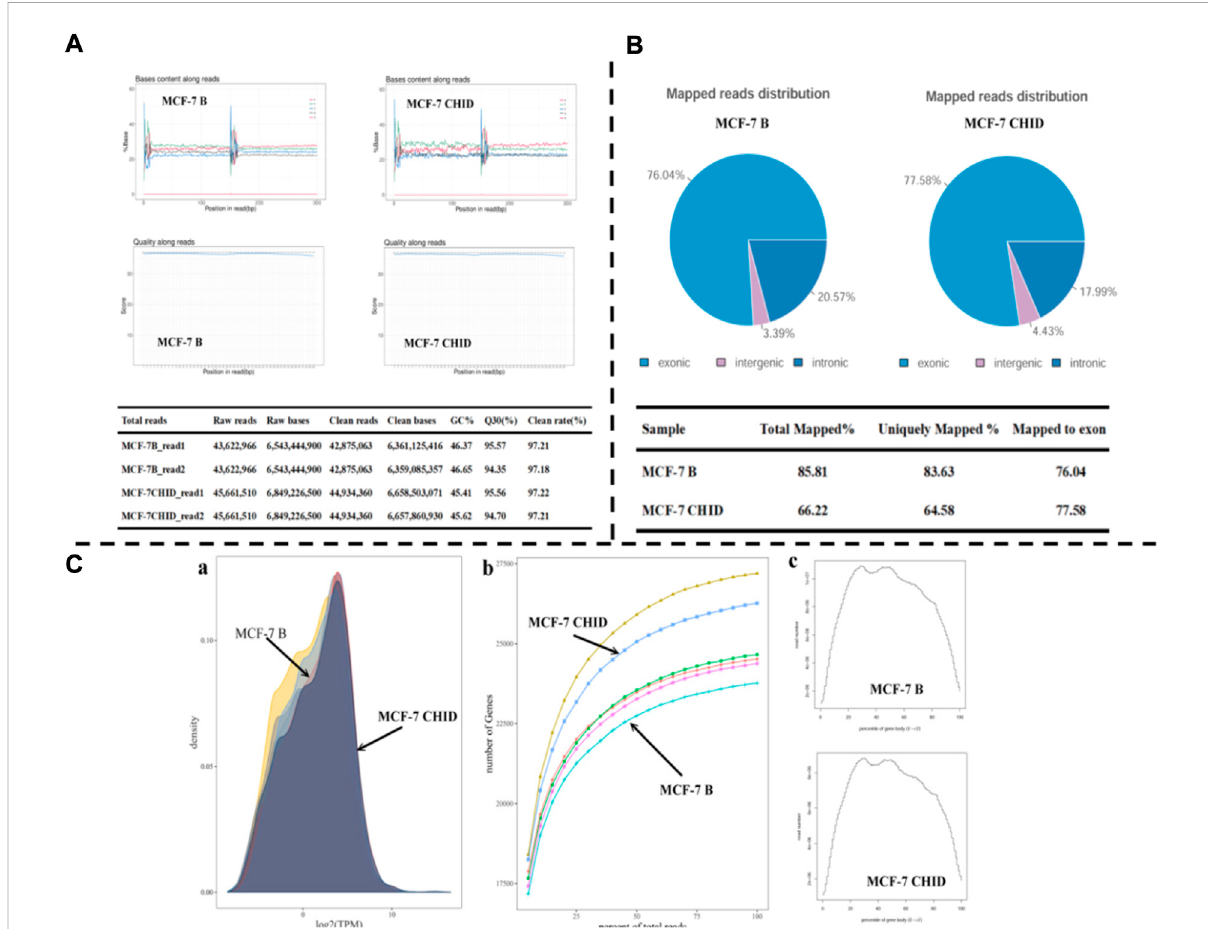
Transcriptome analysis of MCF-7 after Chidamide treatment. (A) : Quality inspection chart of initial data. (B) : Mapping information of RNA-Seq; (C) : a: Gene expression density map; b: Sequencing saturation results for each sample. The horizontal coordinate indicates the amount of sequencing data (expressed as a percentage) and the vertical coordinate indicates the number of genes detected. c: Transcript coverage homogeneity. The horizontal coordinates of the graph indicate the gene length (expressed as a percentage) and the vertical coordinates indicate the number of reads in the